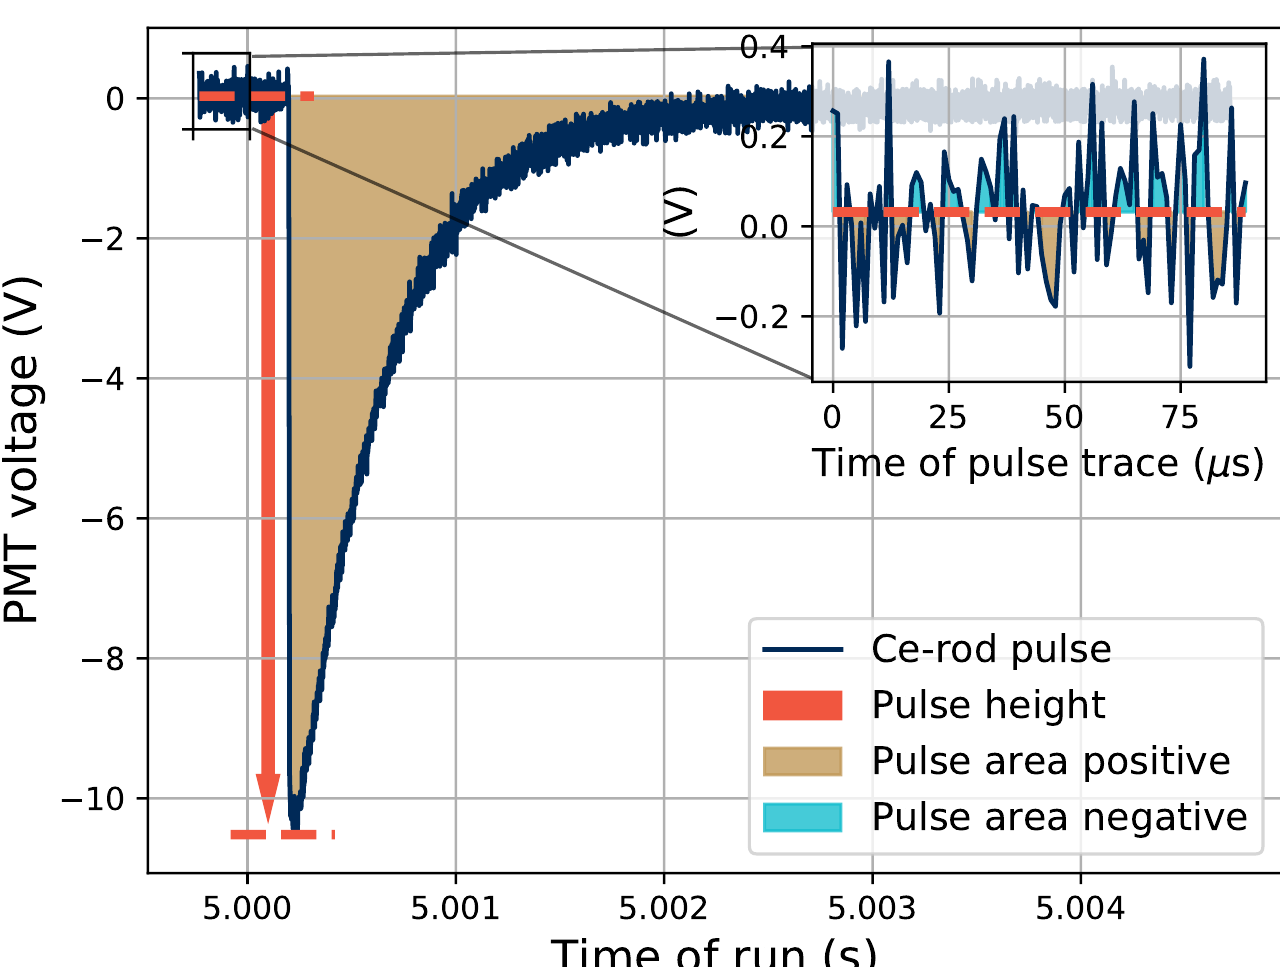
Figure 2. Example of one recorded pulse from a test using the Ce-rod, where the methods of calculating the height and area of the pulses are